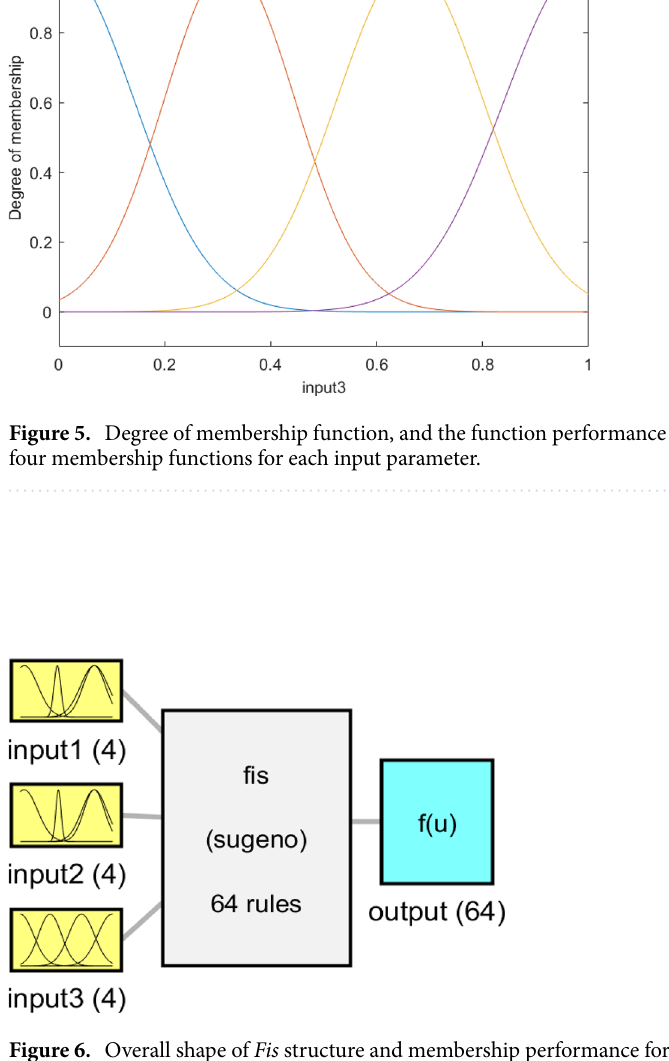
Figure 6. Overall shape of Fis structure and membership performance for each input